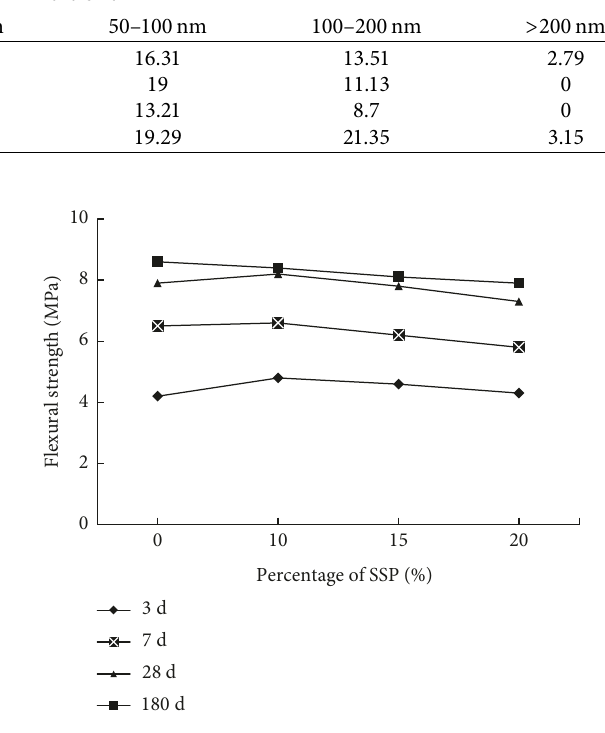
11: The flexural strength of